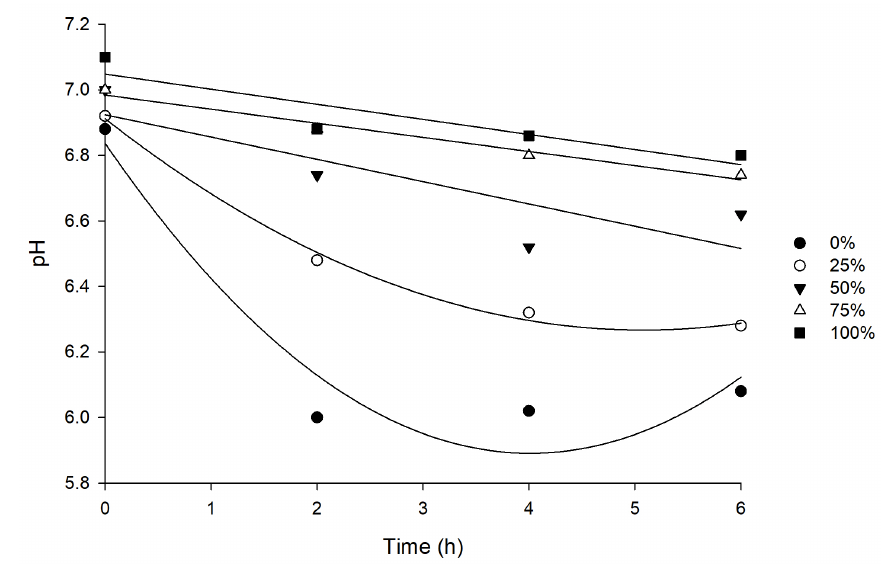
Figure 1. pH values for different replacement levels (0%, 25%, 50%, 65%, 100%) of wheat bran for cactus cladodes plus urea through the time.